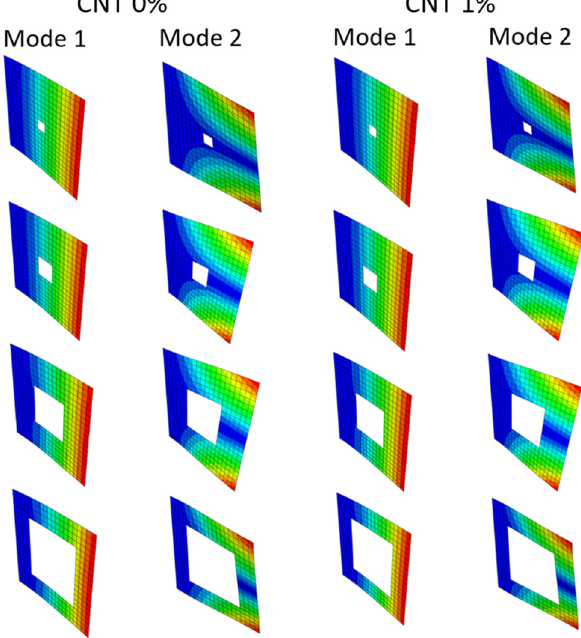
Figure 9: Mode shapes of CNTFPC fl at panels with di ff erent cutout sizes for SWCNT 0% and